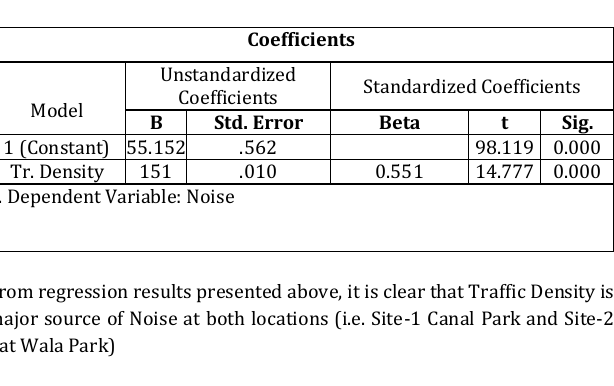
Table 3: Standardized and unstandardized coefficient